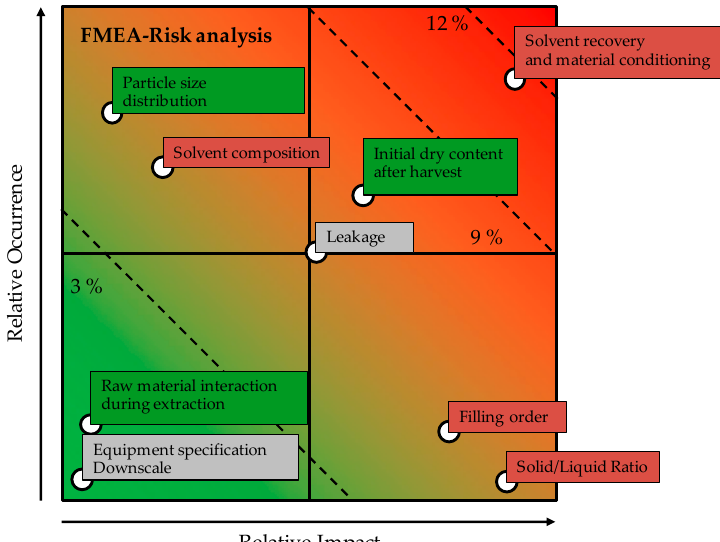
Figure 6. Qualitative failure mode effect analysis (FMEA) for the considered solid-liquid extraction process. The broken lines represent the impact on product quality based on the average value. Risk categories are colored according to the category (red = process, green = material, grey = equipment).